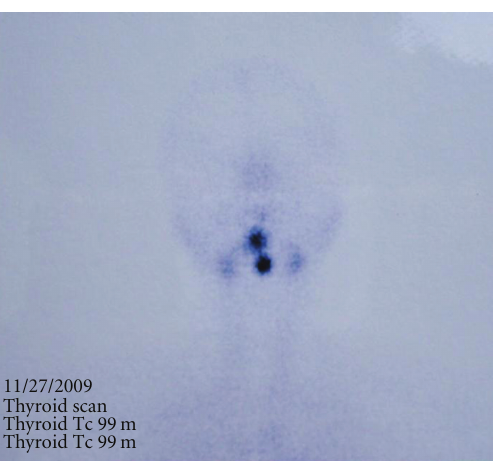
raised TSH with swelling should be put on replacement therapy with thyroid hormone which can produce a slow reduction of the mass [3]. When medical treatment fails or there are obstructive symptoms or haemorrhage or suspicion of malignancy, then surgery should be considered. As malignant transformation has been described,